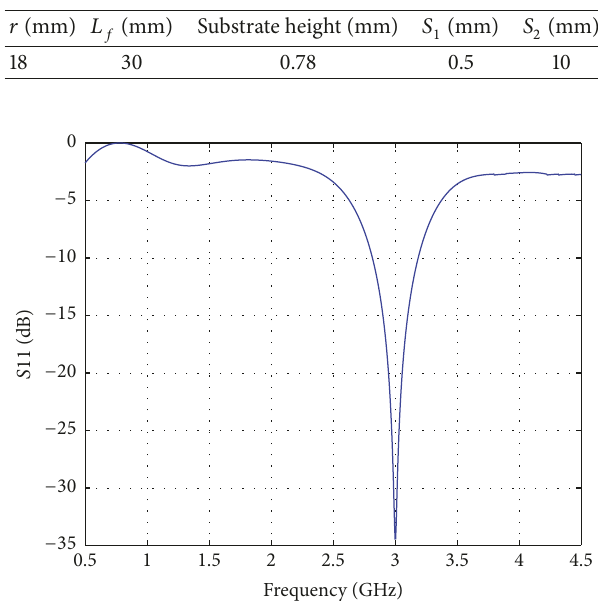
Figure 10: 𝑆 11 of the single band CPW